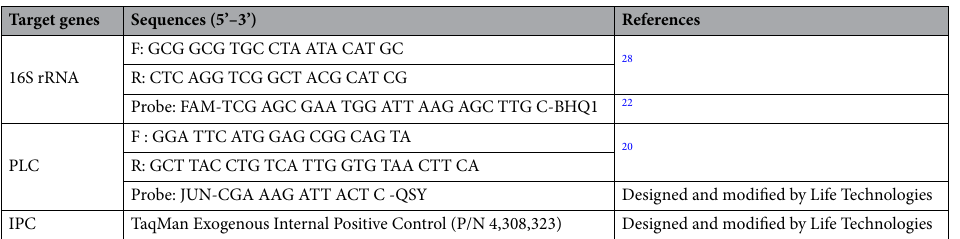
Table 2. PCR Primers used for the multiplex qPCR assays. 16S rRNA 16S ribosomal DNA, PLC phosphatidylcholine-specific Phospholipase C, IPC Internal positive control.